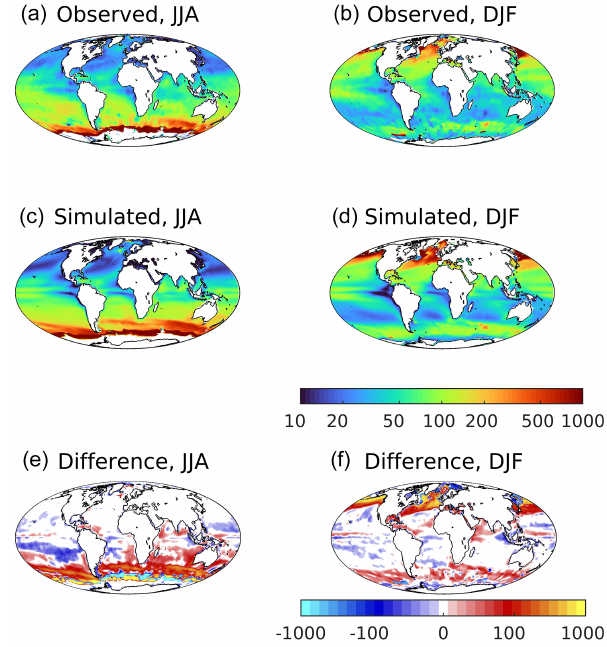
Figure 4. Observationally derived ( a, b ; World Ocean Atlas) and simulated (c, d) mixed-layer depth for northern summer ( a, c, e ; JJA) and southern summer ( b, d, f ; DJF). Differences (simulated– observed) for both seasons shown in the bottom row. Mixed-layer depth derived from full three-dimensional fields of potential tem- perature, using a temperature difference criterion (Monterey and Levitus, 1997). In this, mixed layer depth is the depth at which po- tential temperature differs from that at 5m by 0.5 ◦ C. White regions are those where this criterion fails (i.e. ocean interior temperature is never cooler than that at 5m by the 0.5 ◦ C criterion; typically sea ice covered regions). Mixed layer depth is in metres and shown on a logarithmic scale.